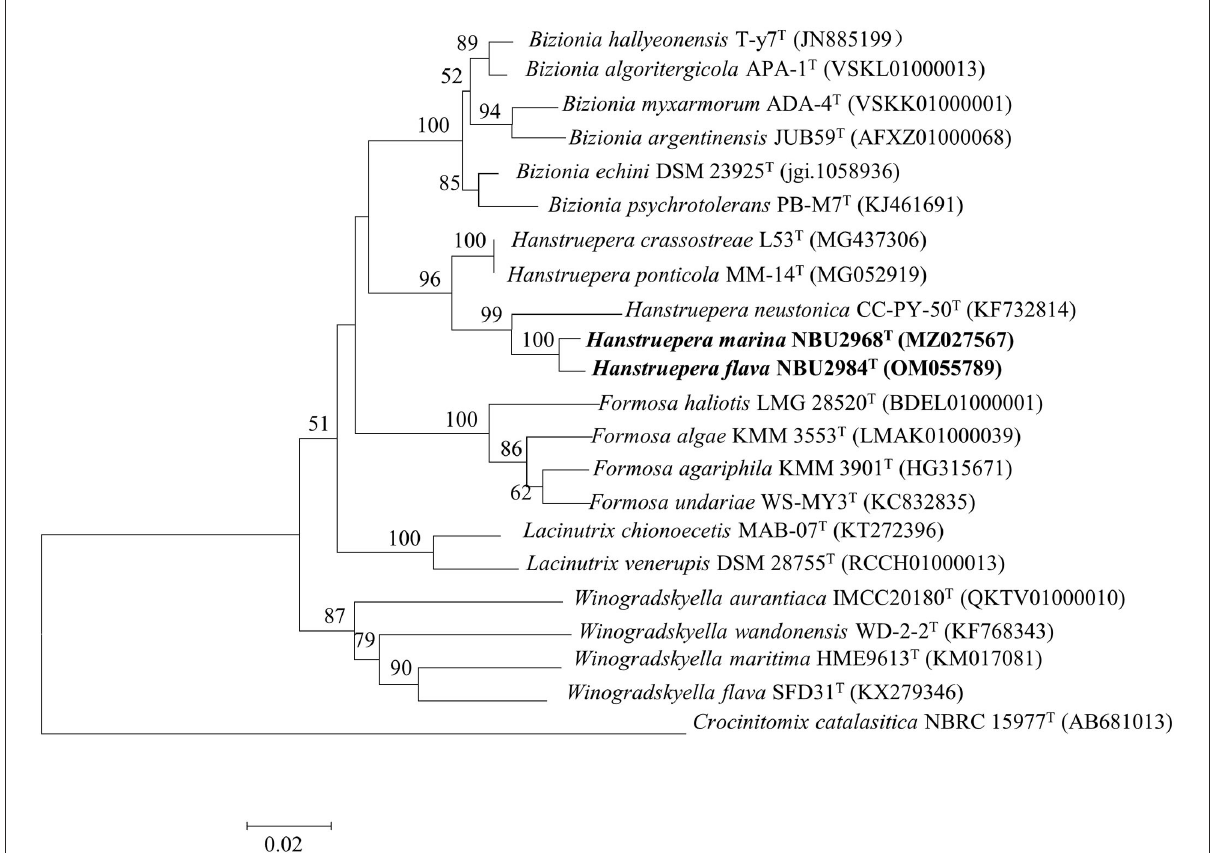
FIGURE2 Neighbor-joining phylogenetic tree based on the 16S rRNA gene sequences, showing the phylogenetic relationships of strains NBU2968 T , NBU2984 T , and related taxa. Bootstrap values are based on 1,000 resamplings. Bootstrap values higher than 50% are indicated at branch points. Bar, 0.02 substitutions per nucleotide